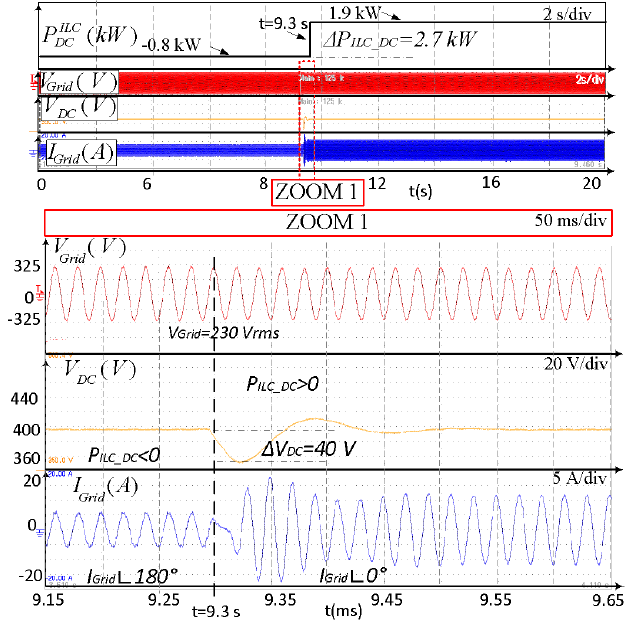
Figure 16. Experiment #3. Experimental results of the abrupt change in power flow from the DC bus to the main